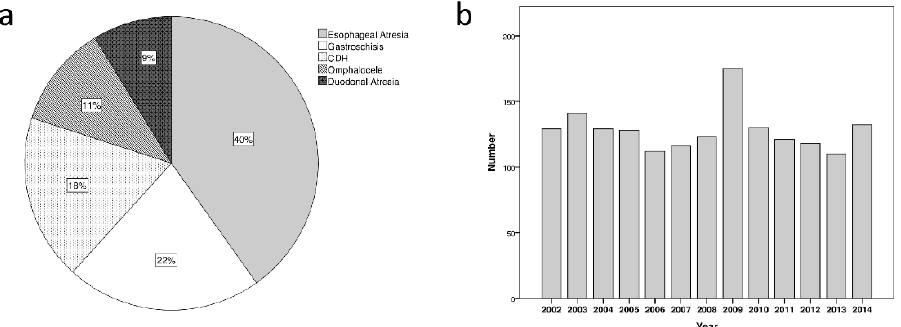
Figure 2. ( a ) In the pie chart the distribution of the five malformations considered is represented. ( b ) The number of hospitalizations for the malformations considered remained similar over the examined years.